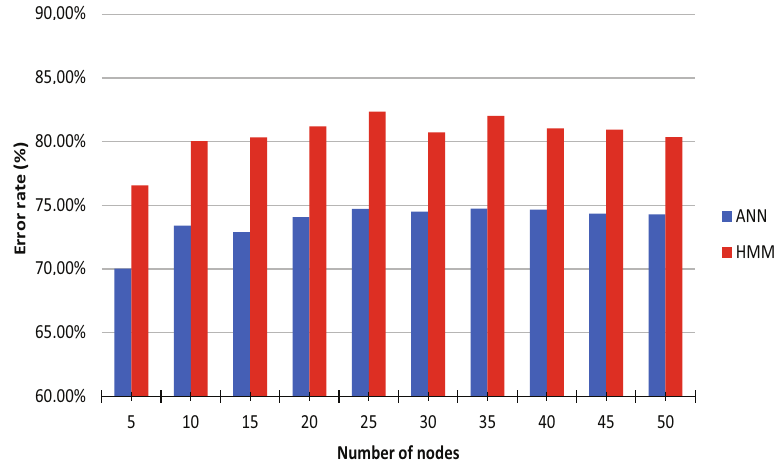
Figure 3. Average recognition rate of artificial neural network (ANN, blue) and HMM (red) using cross validation, wavelet level 3, and a single hidden layer for varying number of nodes in the hidden layer.